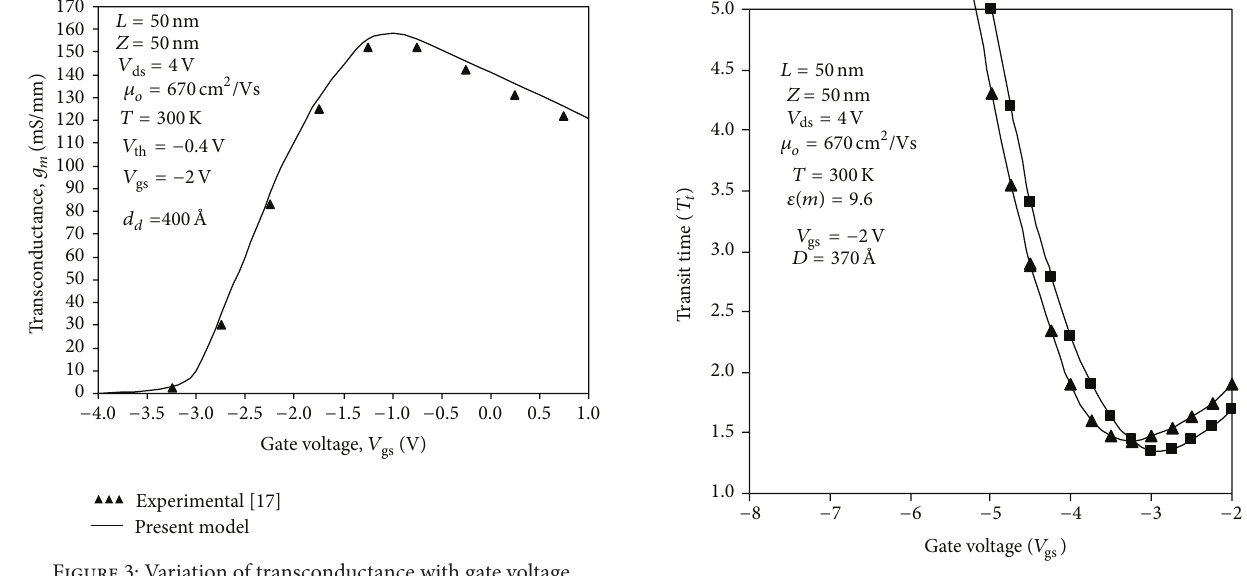
Figure 3: Variation of transconductance with gate voltage.